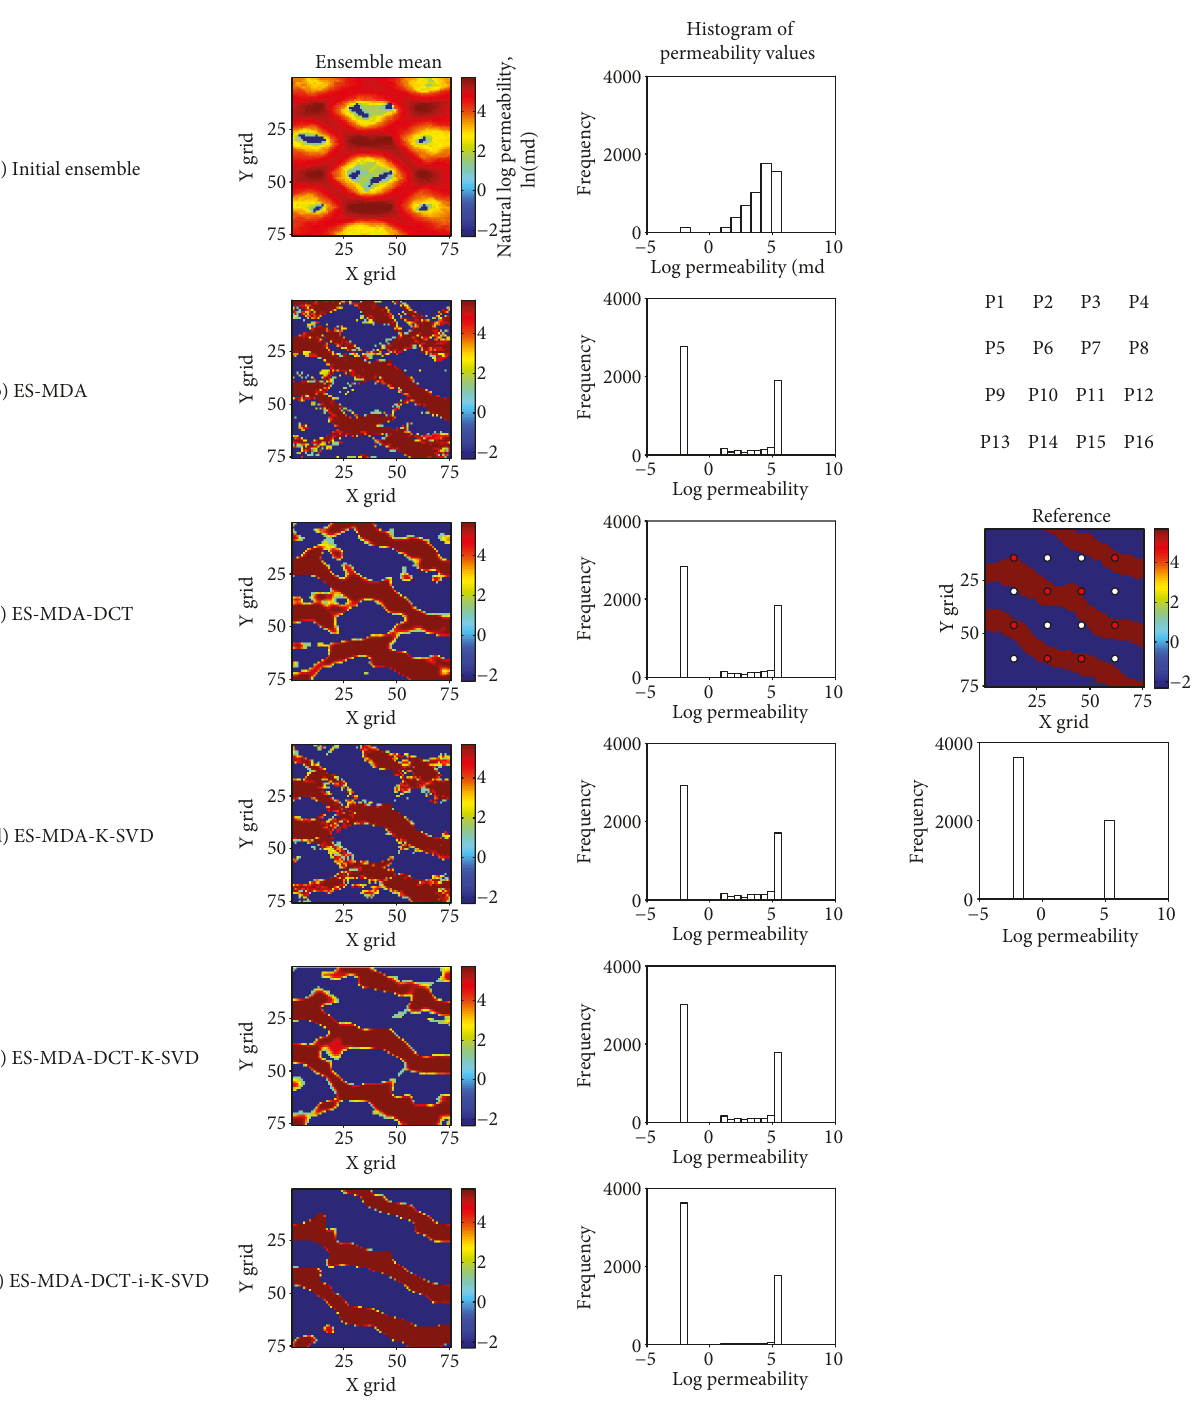
Figure 15: Permeability distribution of the ensemble means and their histogram of permeabilities obtained after history matching of Case